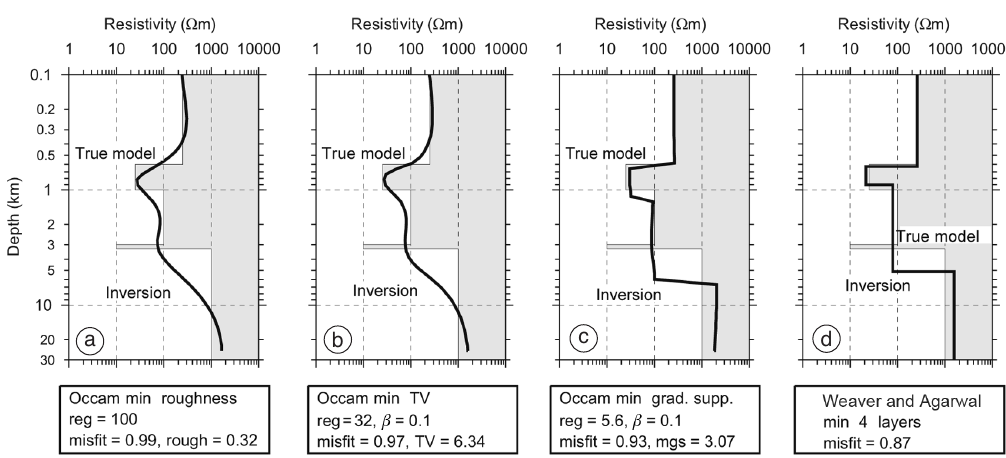
Fig. 1a-d. Results of four different linearized inversion routines applied to the synthetic data set DSI. The da- ta generating model is marked by a gray-white contrast in all sub-panels, and its layer parameters are: layer 1 – h 1 = 0.6 km, ρ 1 = 250 Ω m; layer 2 – h 2 = 0.4 km, ρ 2 = 25 Ω m; layer 3 – h 3 = 2 km, ρ 3 = 10 Ω m; layer 4 – h 4 = 0.25 km,